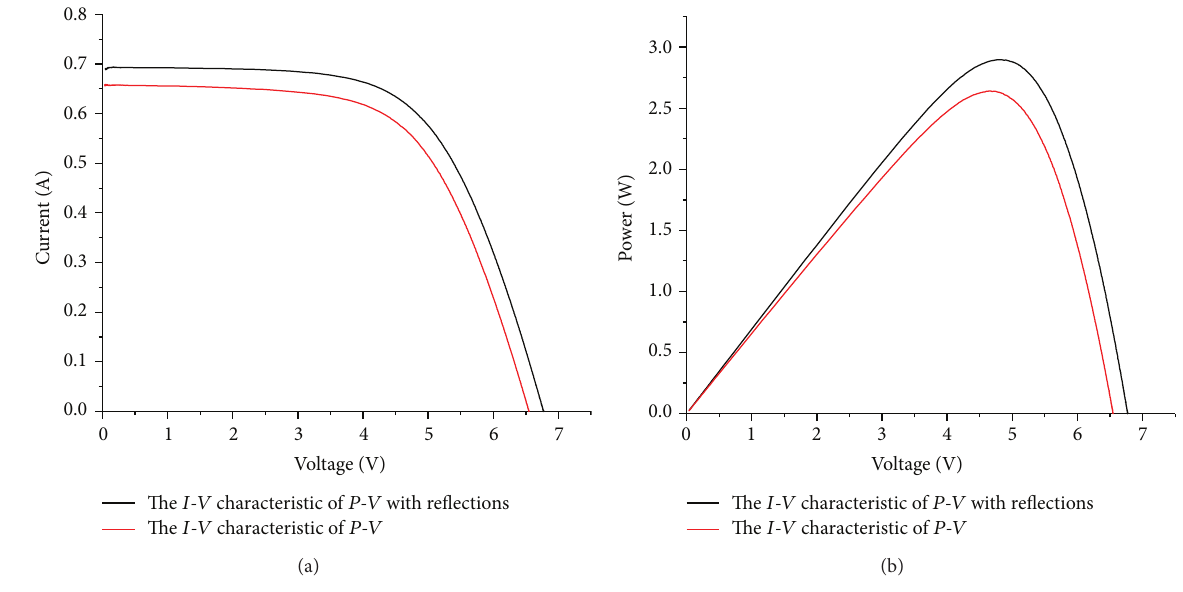
Figure 3: The I - V (a) and P - V (b) characteristics for two photovoltaic panels at the 990 W/m 2 irradiance.